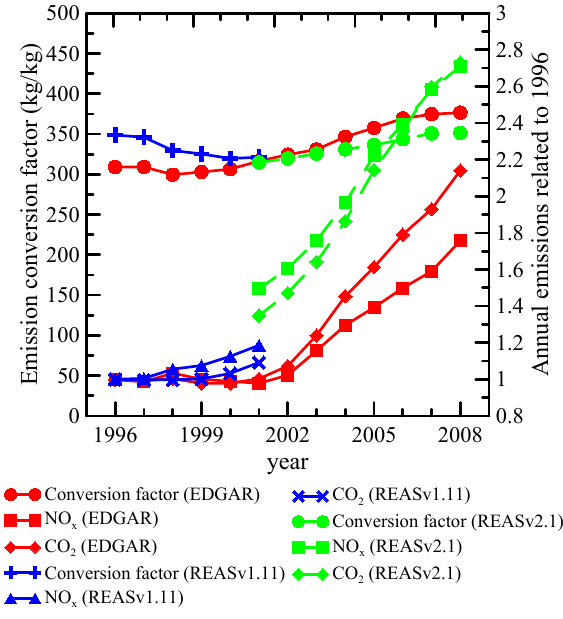
Fig. 2. Multiannual evolution of the CO 2 and NO x anthropogenic emissions in China and the behavior of the corresponding NO x - to-CO 2 emission conversion factor F (see Eq. 8) according to the EDGAR v4.2 and REAS (v1.11 and v2.1) emission invento- ries. The emissions are normalized to their values in 1996. Note that the version 1.11 of the REAS inventory was used for the first (1996-2001) period analyzed in this study, because the REAS v2.1 inventory was not available for this period.